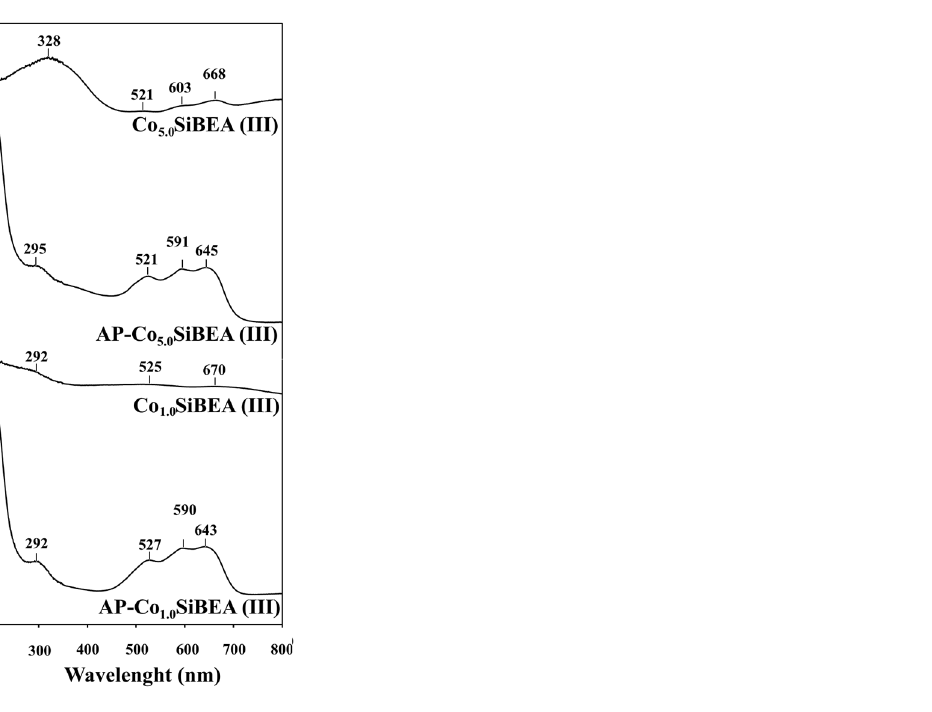
Figure 7. DR UV-vis spectra of selected samples of AP-Co x SiBEA(III) and Co x SiBEA(III) series recorded at room temperature and under ambient atmosphere.